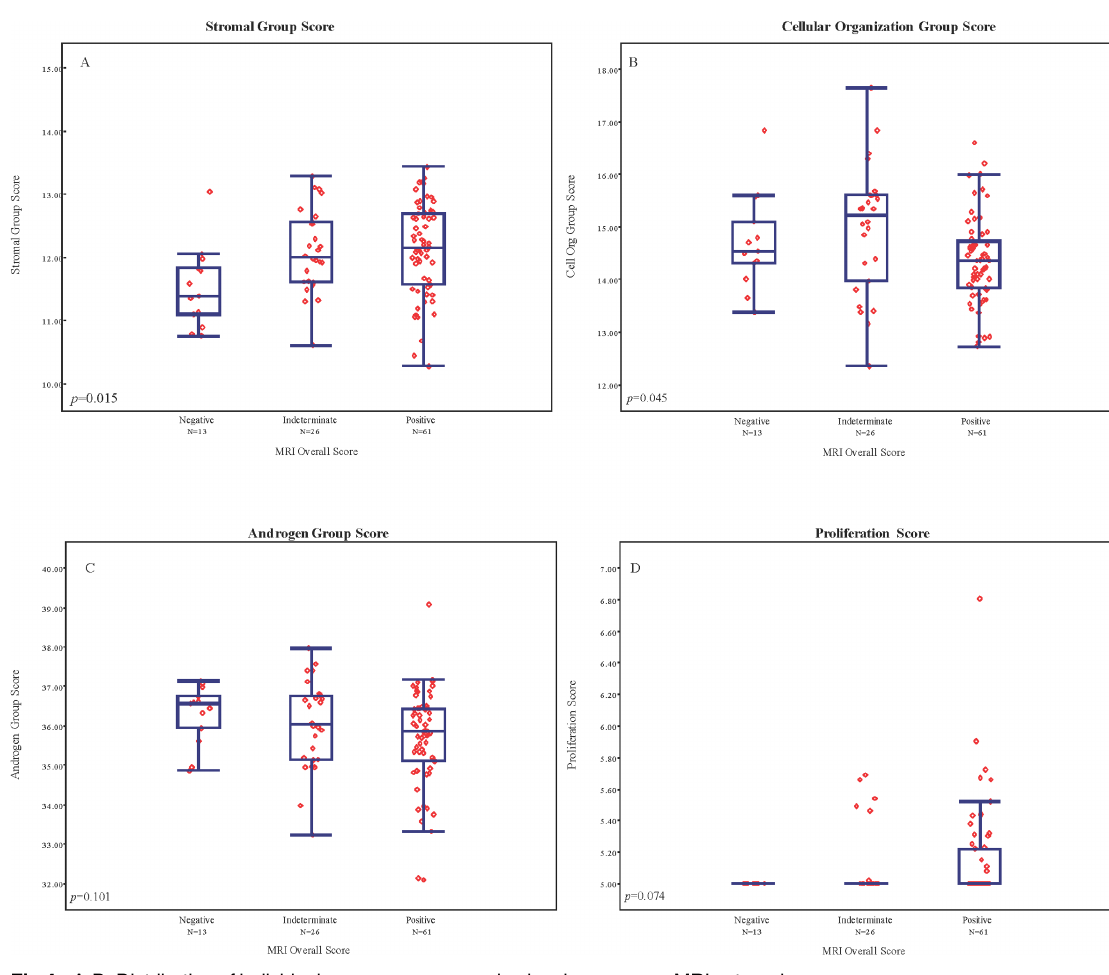
Fig 4. A-D. Distributionof individualgene group expressionlevels among mpMRI